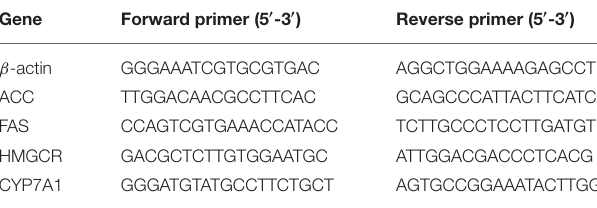
TABLE 1 | Primer sequences used for